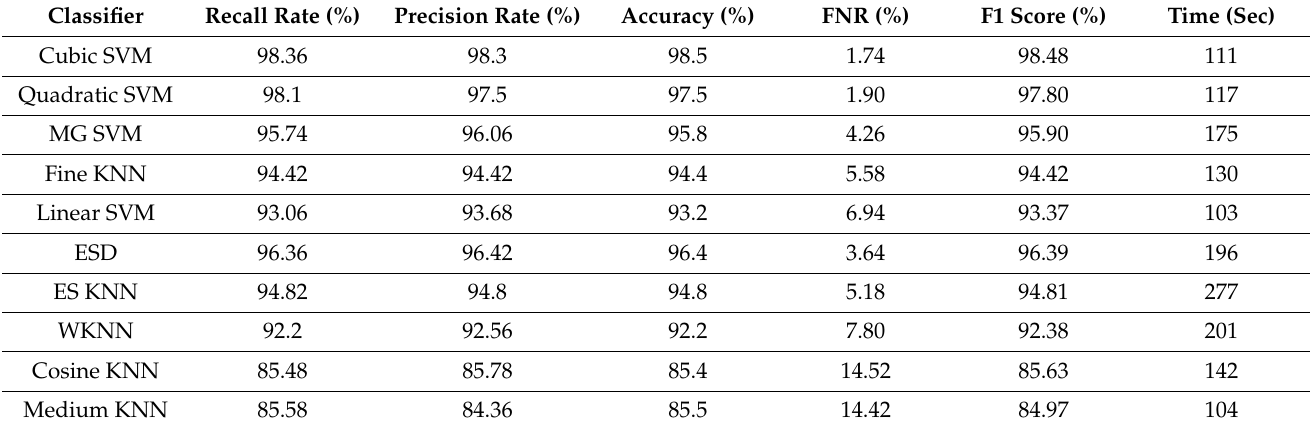
Table 9. Proposed framework classification results using augmented